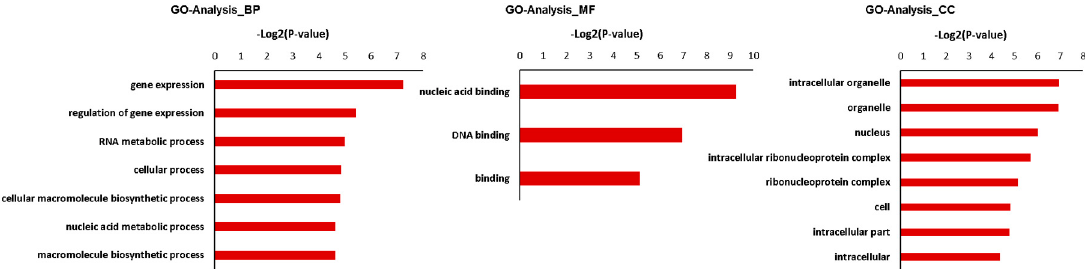
Figure 5. GO analysis for targeted genes of representative differentially expressed miRNA. − Log2 (P-value) of the corresponding biological process (BP), molecular function (MF), and cellular component (CC). Log2 (P-value) is the negative logarithm of P-value; a bigger Log2 (P-value) indicates a smaller P-value. The data are presented in Supplementary Tables S5 and S6.